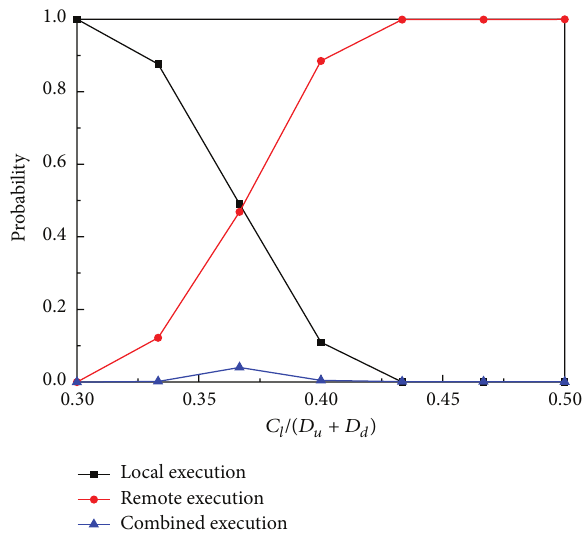
Figure 3: Probability of adopting three execution modes.